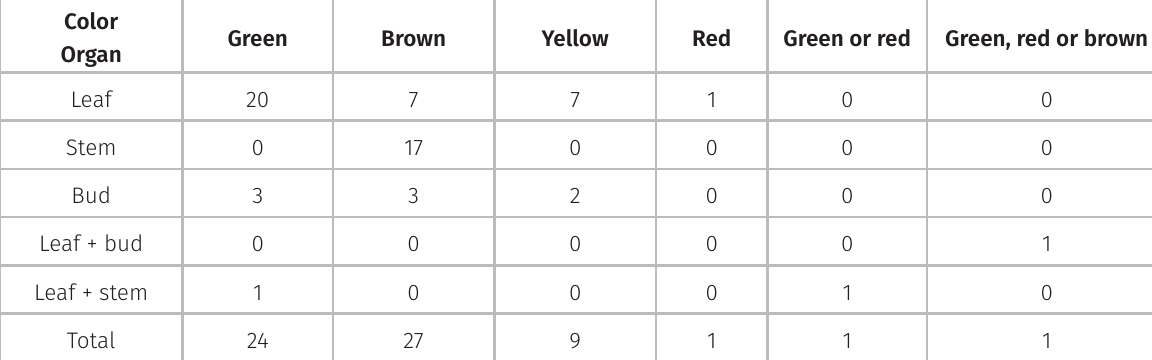
Table V. Richness of insect galls per gall-inducing taxa and plant organ in the Natural Heritage Private Reserve of Serra Negra do Funil (Minas Gerais, Brazil). Inducer Cecidomyiidae Tephritidae Organ (Diptera)